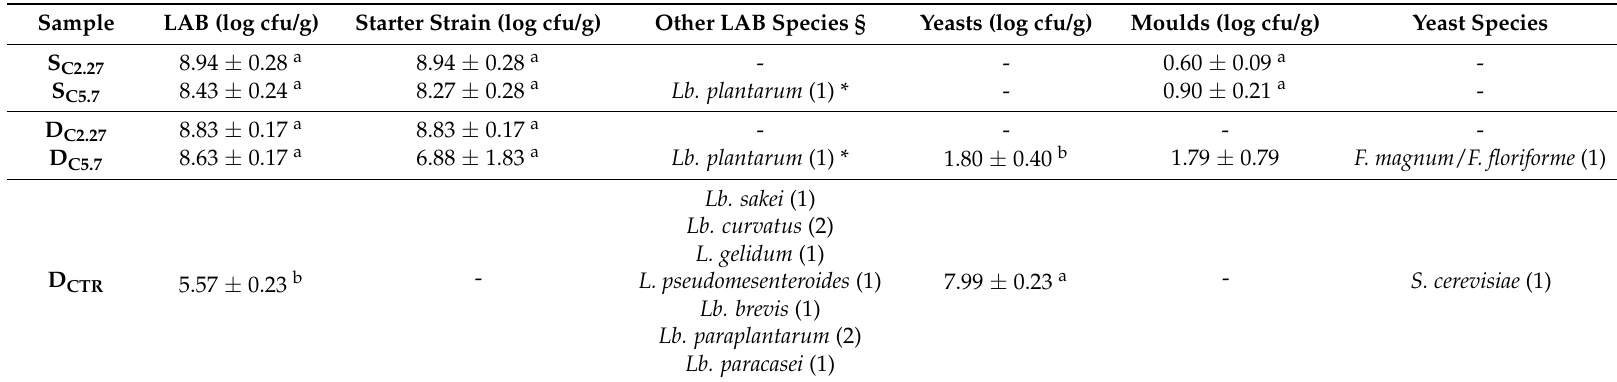
Data represent means of three independent experiments ± standard error. a,b Values refer to liquid sourdough or to bread dough in the same column, where different letters differ significantly ( p < 0.05). Lb. , Lactobacillus ; L. , Leuconostoc ; S. , Saccharomyces ; F. , Filobasidium . § Bacterial species identified in liquid sourdoughs and bread doughs that were different from those of the starter strains ( L. citreum and W. confusa ). * The same single strain was identified in S C5.7 and in D C5.7 . (1) A single strain was identified on the basis of the rep-PCR profile. (2) Two different strains belonging to the same species were identified on the basis of the rep-PCR